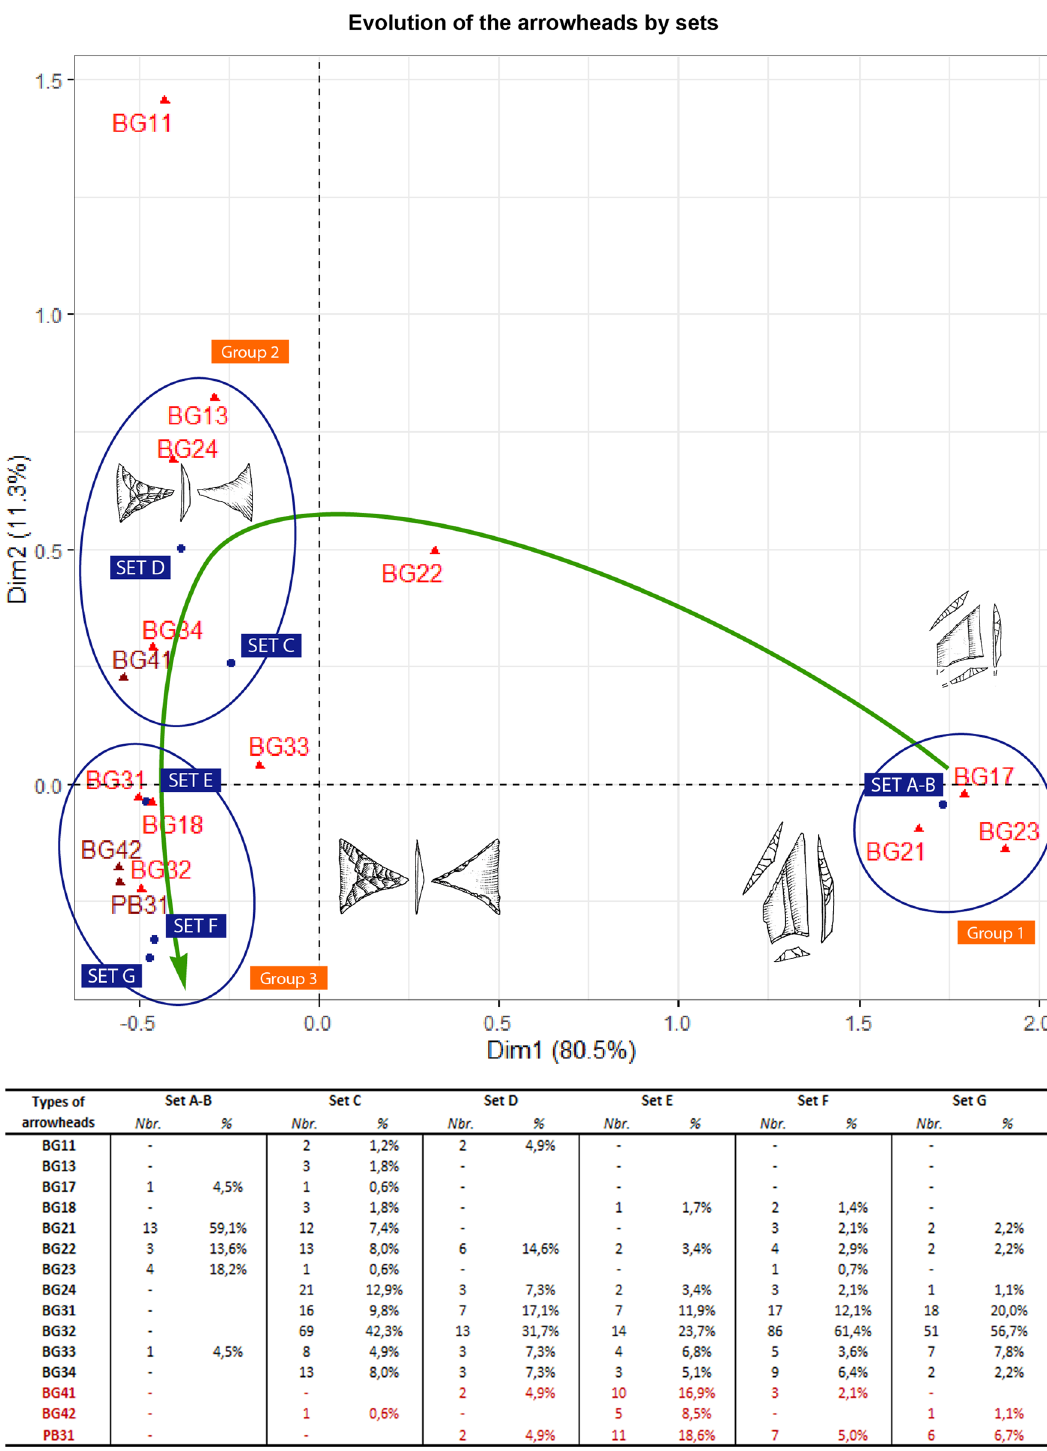
Figure 11: FCA based on the percentages of the main lithic arrowhead classes by archaeological sets. The dots correspond to the archeological sets and the triangles to the di ff erent types of tools. The dark triangles correspond to the supplementary elements. Drawings: R. Picavet et J. - B.